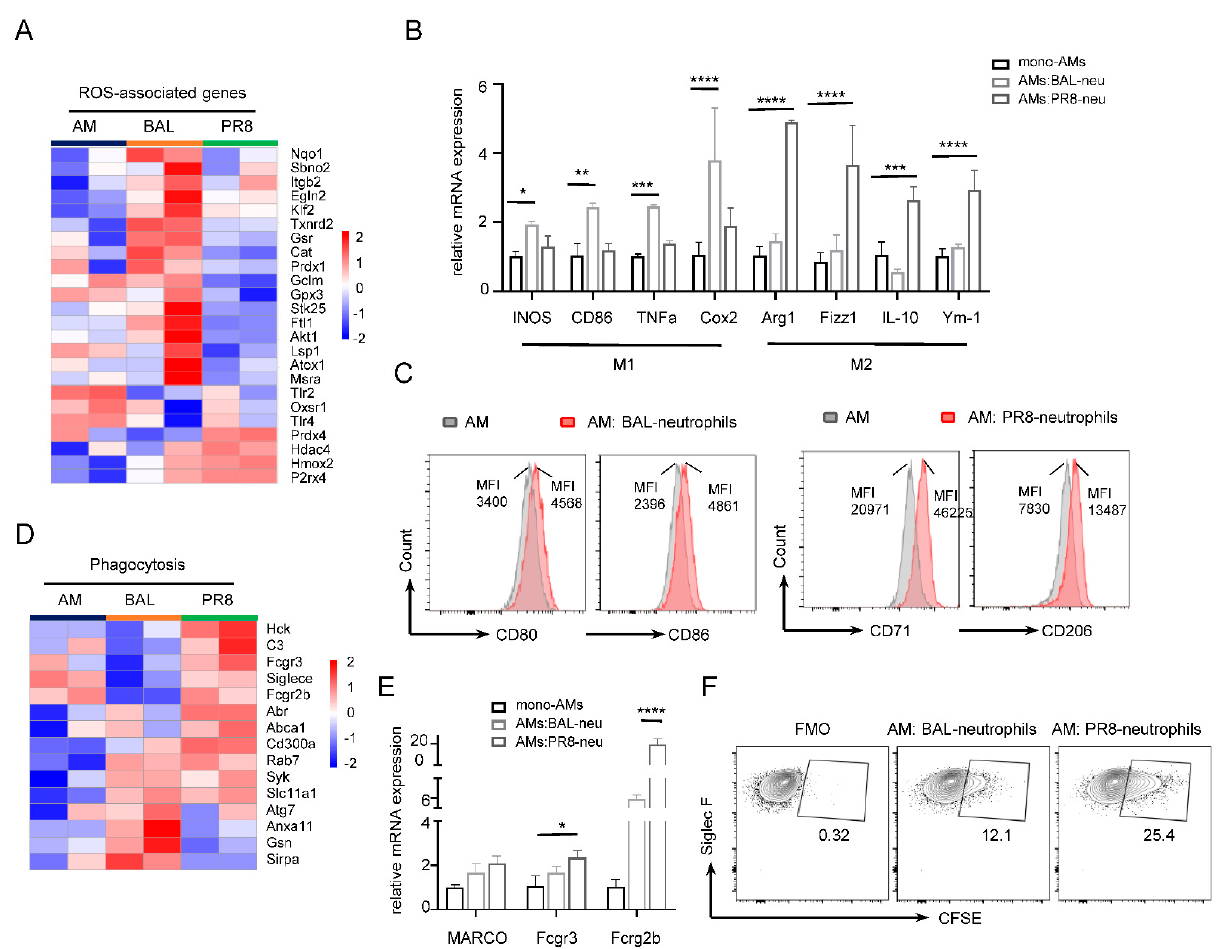
Figure 5. Neutrophils regulate AM polarization and phagocytosis. ( A ) Heatmap showing differentially expressed genes associated with ROS − associated genes in three groups. ( B ) The mRNA expression of M1 and M2 − accociated genes of AMs from AMs (alone), AM: BAL–neutrophils (AMs: BAL–neu), and AM: PR8–neutrophils (AMs: PR8–neu). ( C ) Flow cytometry analysis of MFI of CD80, CD86, CD71, and CD206 from AMs co-cultured with BAL–neutrophils or PR8–neutrophils compared to AMs. ( D ) Heatmap showing macrophage − associated phagocytosis genes in AMs from AM (mono-cultured AMs) and BAL groups (co-culture for AMs and BAL–neutrophils), and PR8 (co-culture for AMs and PR8–neutrophils) groups. ( E ) The mRNA of MARCO, Fcgr3, and Fcgr2b of AMs from AMs (alone), AM: BAL–neutrophils (AMs: BAL–neu), and AM: PR8–neutrophils (AMs: PR8–neu). ( F ) Representative flow cytometry plots of CFSE − labeled neutrophils population in gated AMs. Data are presented as arithmetic mean ± SD. * p < 0.05; **, p < 0.01; ***, p < 0.001; **** p <